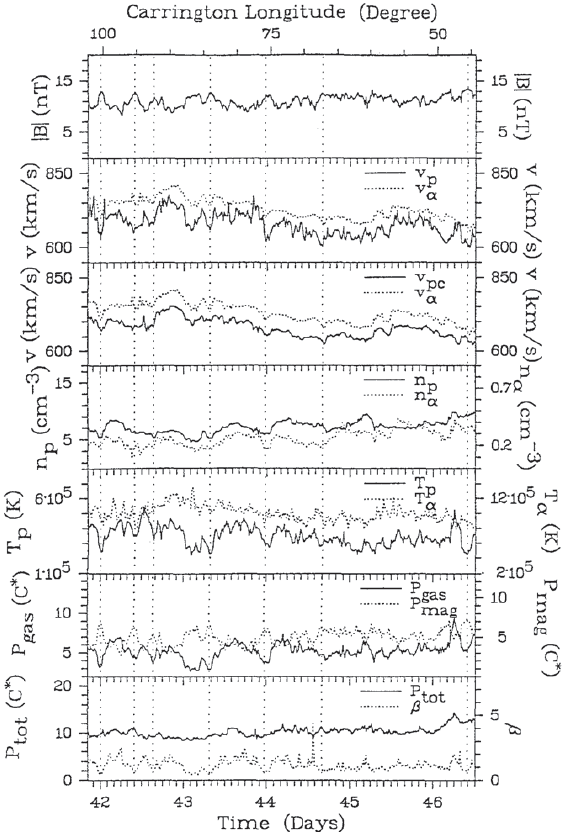
Figure 73: From top to bottom: field intensity | B | ; proton and alpha particle velocity 𝑣 𝑝 and 𝑣 𝛼 ; corrected proton velocity 𝑣 𝑝𝑐 = 𝑣 𝑝 − 𝛿𝑣 𝐴 , where 𝑣 𝐴 is the Alfv´en speed; proton and alpha number density 𝑛 𝑝 and 𝑛 𝛼 ; proton and alpha temperature 𝑇 𝑝 and 𝑇 𝛼 ; kinetic and magnetic pressure 𝑃 𝑘 and 𝑃 𝑚 , which the authors call 𝑃 gas and 𝑃 mag ; total pressure 𝑃 tot and 𝛽 = 𝑃 gas /𝑃 mag (from Tu and Marsch,